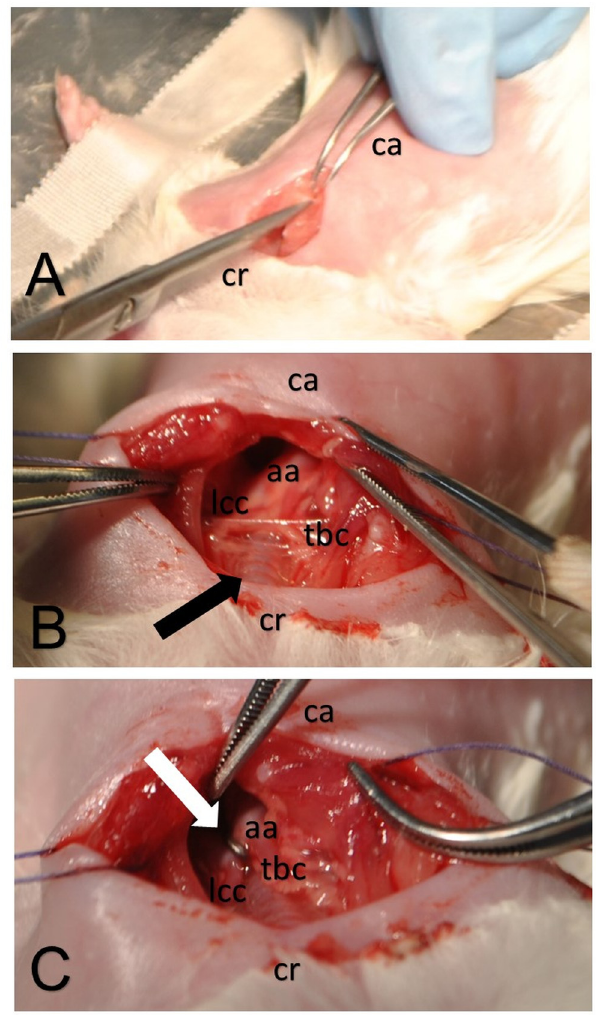
Fig 1. Surgical steps for transverse aortic constriction in three-week old Lewis rats. Upper hemisternotomy for access to aortic arch is performed with scissor from cranial (cr) to caudal (ca) (A). Brachiocephalic trunc (tbc) exits ascending aorta (aa) before trachea (black marker) is crossed and left common carotid (lcc) after trachea is crossed (B). Clip (white marker) is placed between tbc and lcc